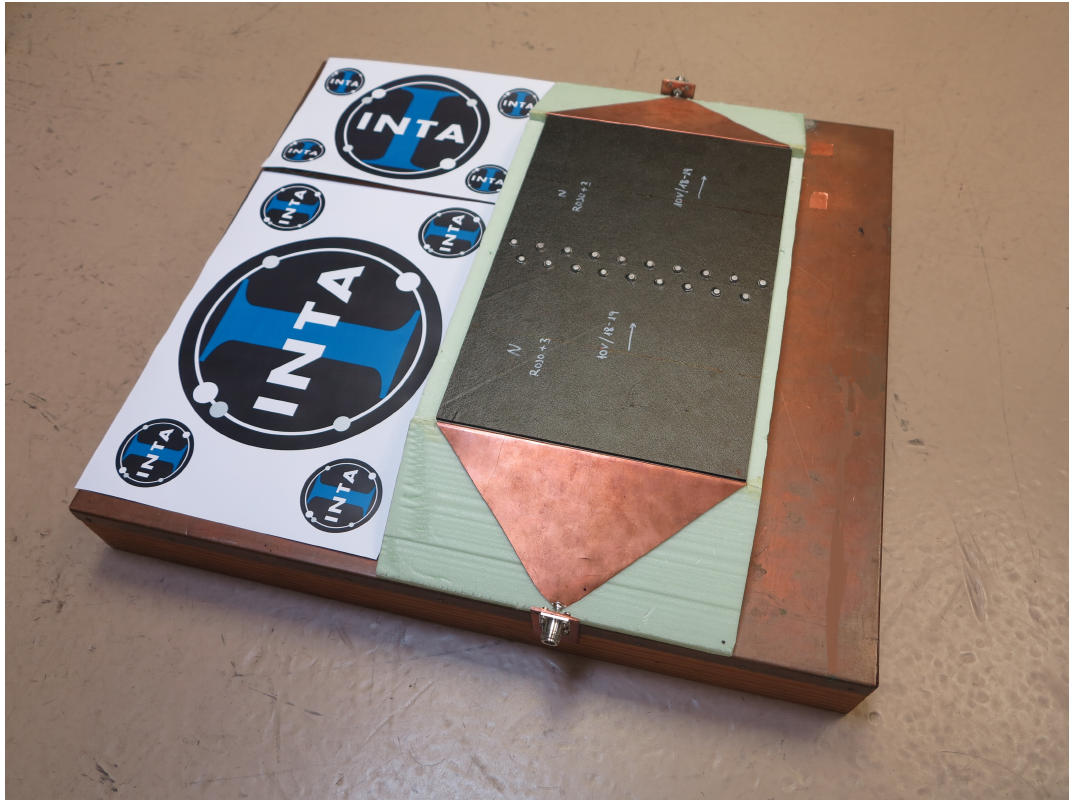
Figure 3. Microstrip line configuration for characterize the joints present in the MILANO